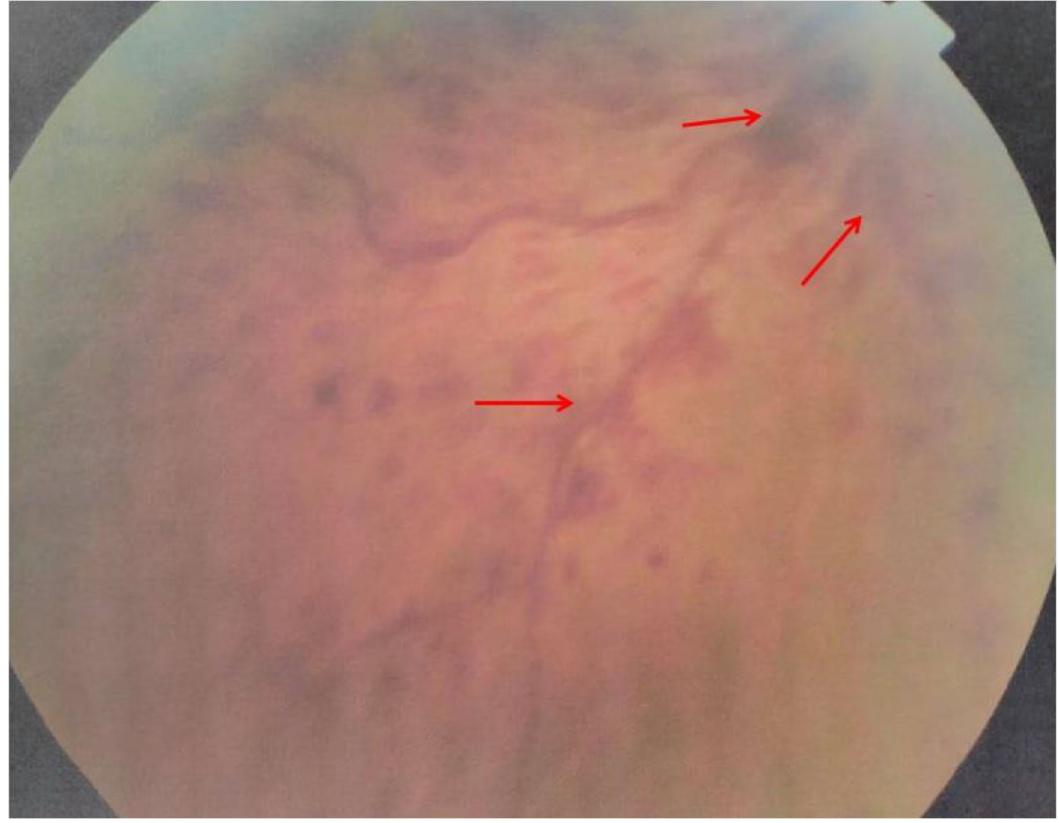
Figure 1. Superficial flame-shaped retinal hemorrhages in fundus